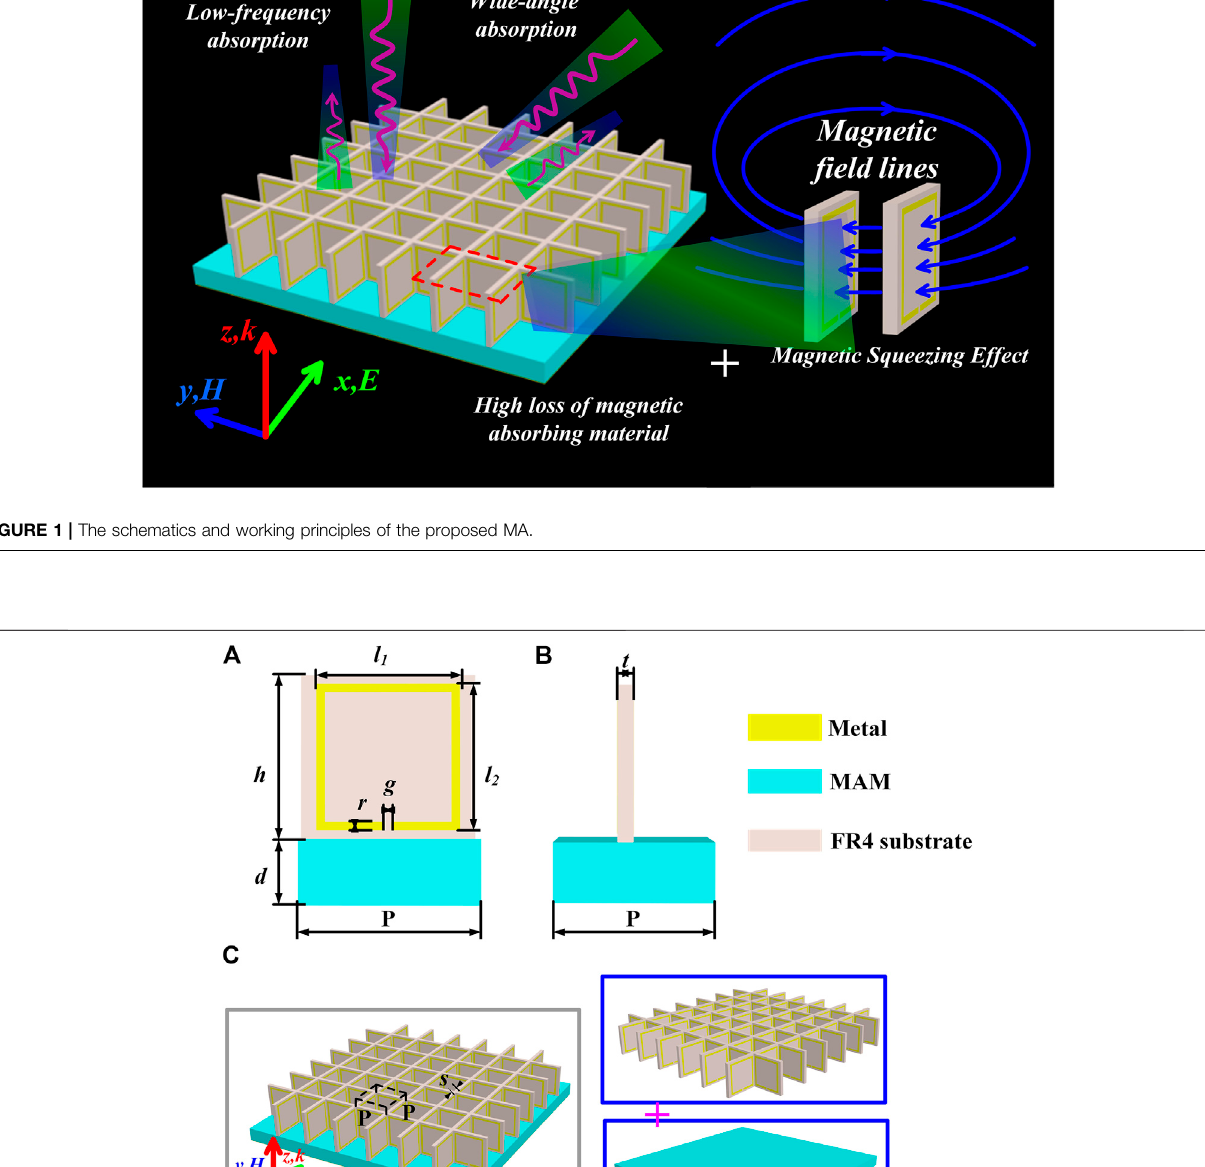
Frontiers in Physics |